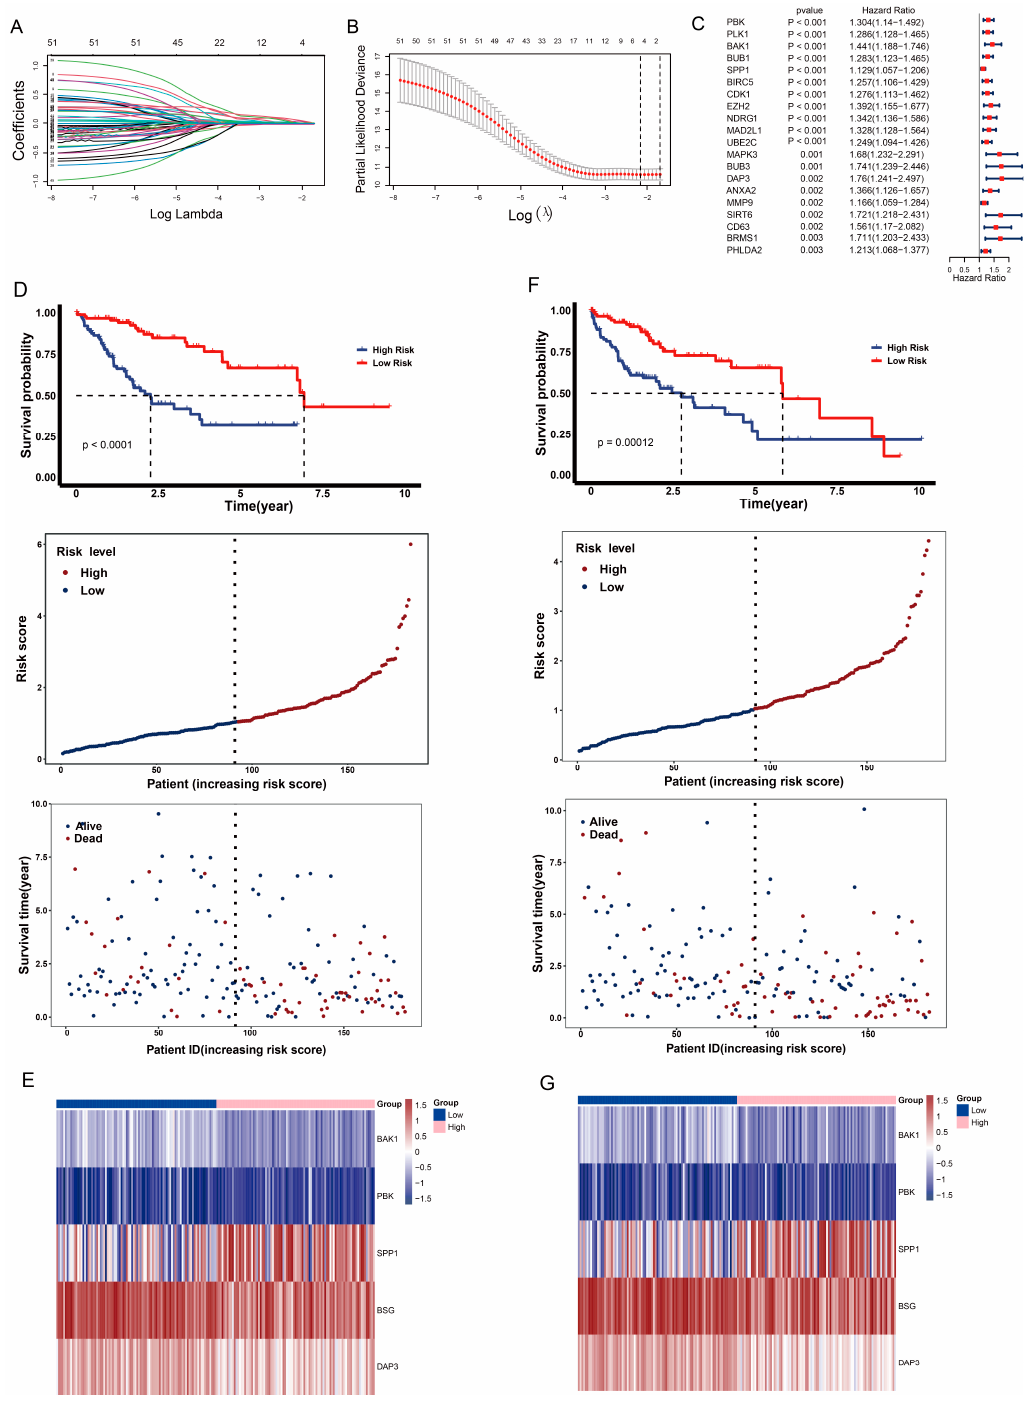
Figure 5. Construction of an anoikis-related prognostic risk model. ( A ) Coefficient curve. Different colors represent different genes. No zero values were selected as a penalty coefficient. ( B ) The